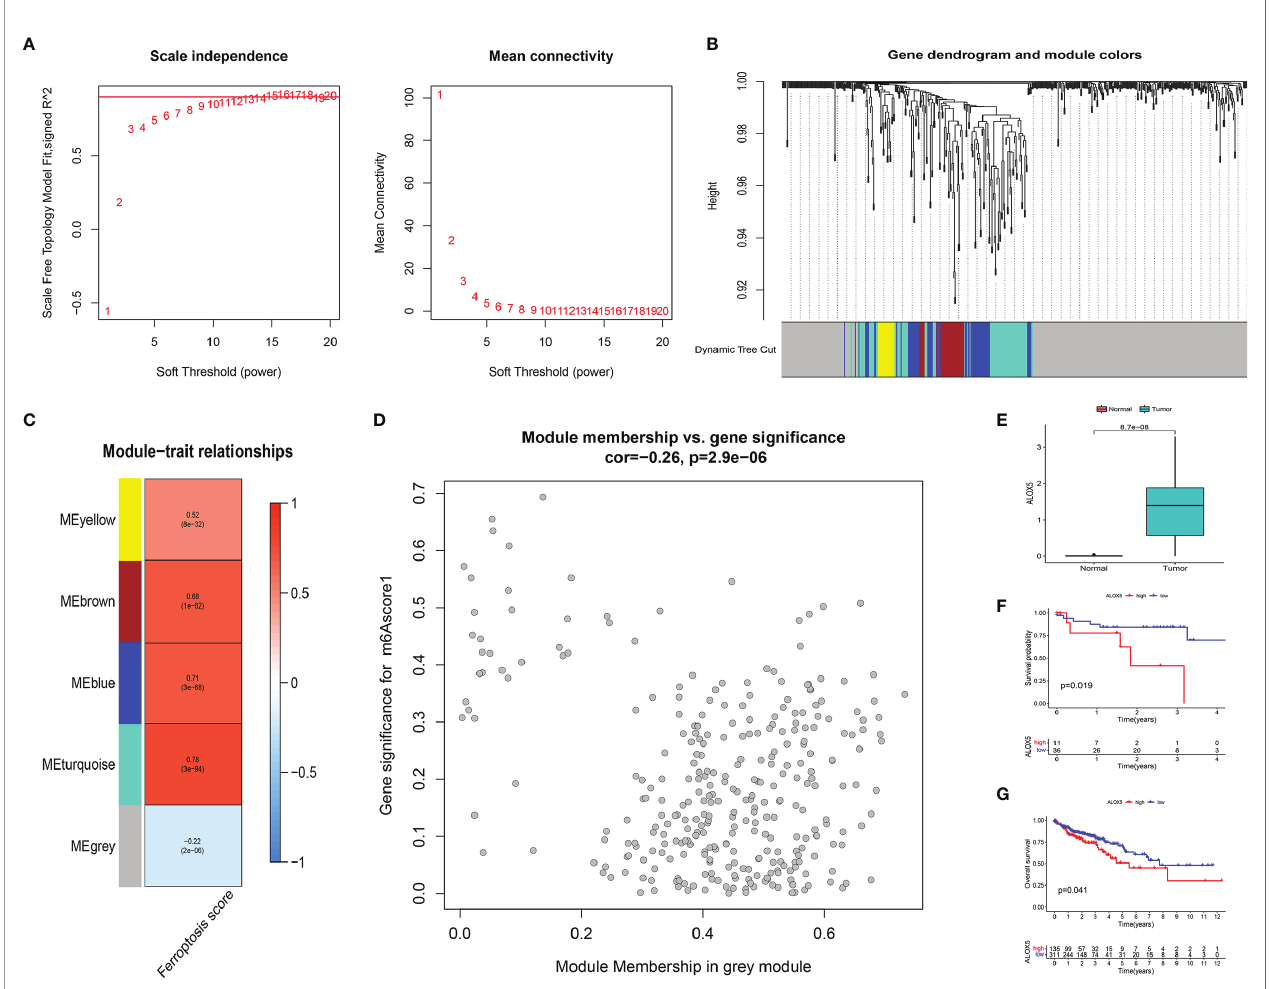
FIGURE 8 | (A) The power index 10 was chosen as the appropriate soft threshold, and a scale-free co-expression network was achieved. (B) The branches of the dendrogram correspond to 5 gene modules. (C) The correlation coef fi cient and corresponding p -value between each gene module and FS are in boxes. (D) Scatter plot of module eigengenes in the gray module. (E) There were signi fi cant differences in ALOX5 expression between cancer tissues and normal tissues at protein level ( p < 0.001). The statistical difference was compared by the Wilcoxon test. (F, G) Kaplan – Meier curves showed overall survival difference between high and low ALOX5 expression groups at protein level ( p = 0.019) (F) and RNA level ( p = 0.041) (G) . FS, ferroptosis